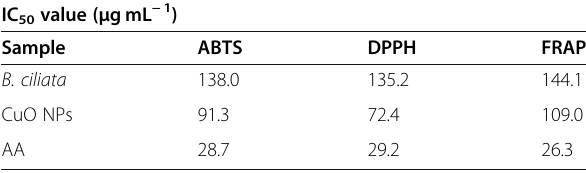
Table 1 Antioxidant activity of B. ciliata and CuO